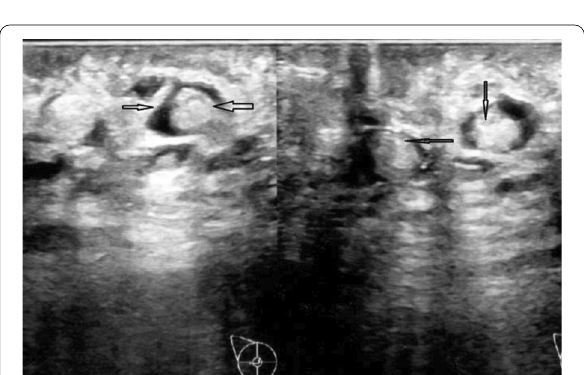
Fig. 4 Multiple dilated duct with echogenic solid areas in retroareolar region, later proved to be intraductal papillomas on cytology in a patient of 46 years of